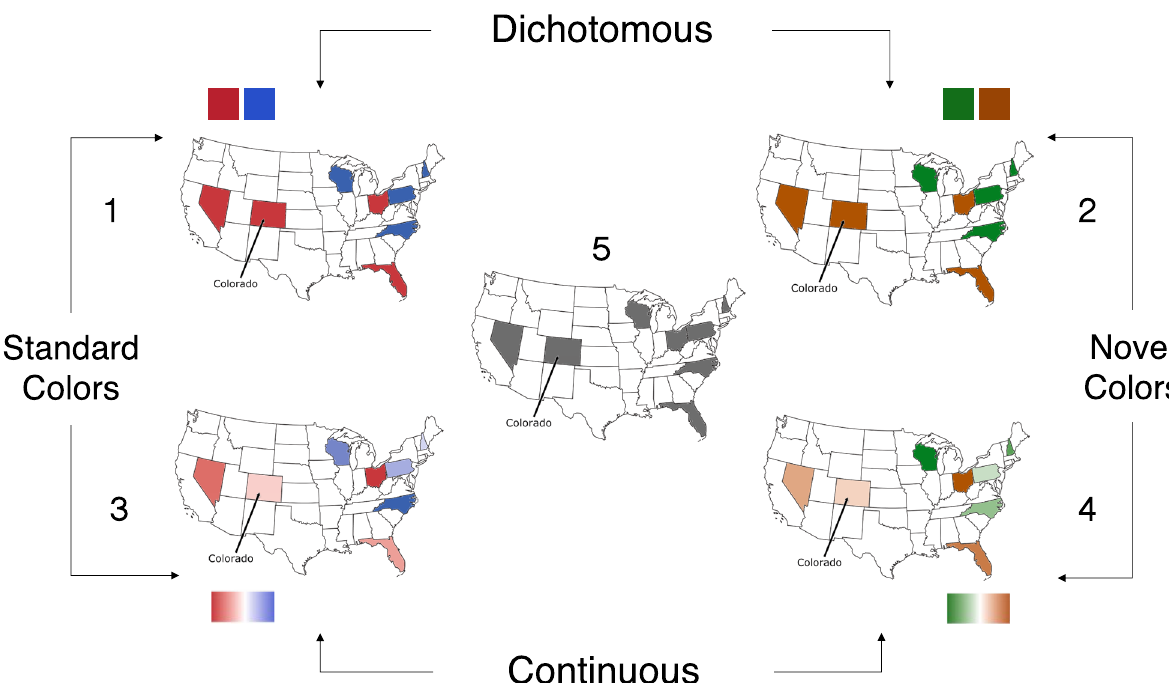
Fig. 2 Sample Polarization Task stimuli for each of the five between-subject conditions: (1) red/blue dichotomous, (2) red/blue continuous, (3) orange/green dichotomous, and (4) orange/green continuous, and (5) uniform gray. Within the four hue varying conditions, the colors assigned to each state were randomized across participants, but the states were always divided evenly across the two hue categories. On each of the eight trials a participant completed, the position of the line with the arrow identified which of the 8 states the participant was judging. Note that the colors assigned to each state remained constant across a single participant’s